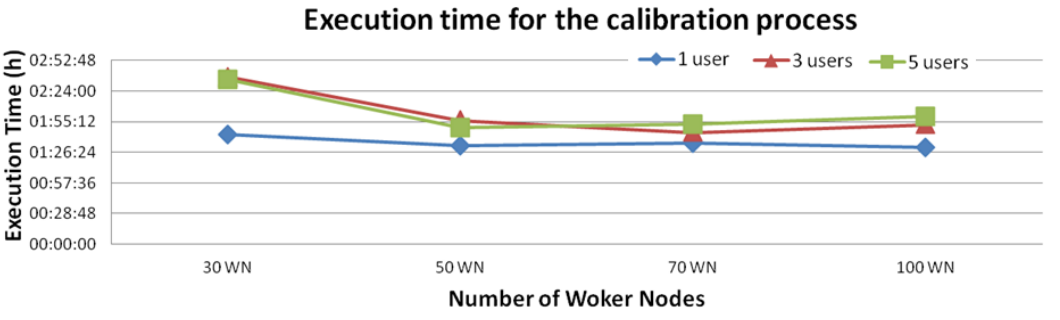
Fig. 13. Calibration time as a function of number of workers and number of current